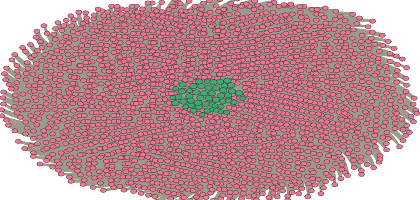
Figure 3: The Sample/Grain-Size bipartite weighted network model.